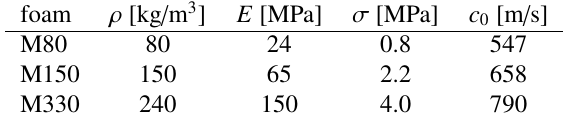
Figure 1: SEM images of freshly milled surfaces of Sikablock foams with 300X magnifica- tion. Table 1: Mechanical properties of foams being investigated in this